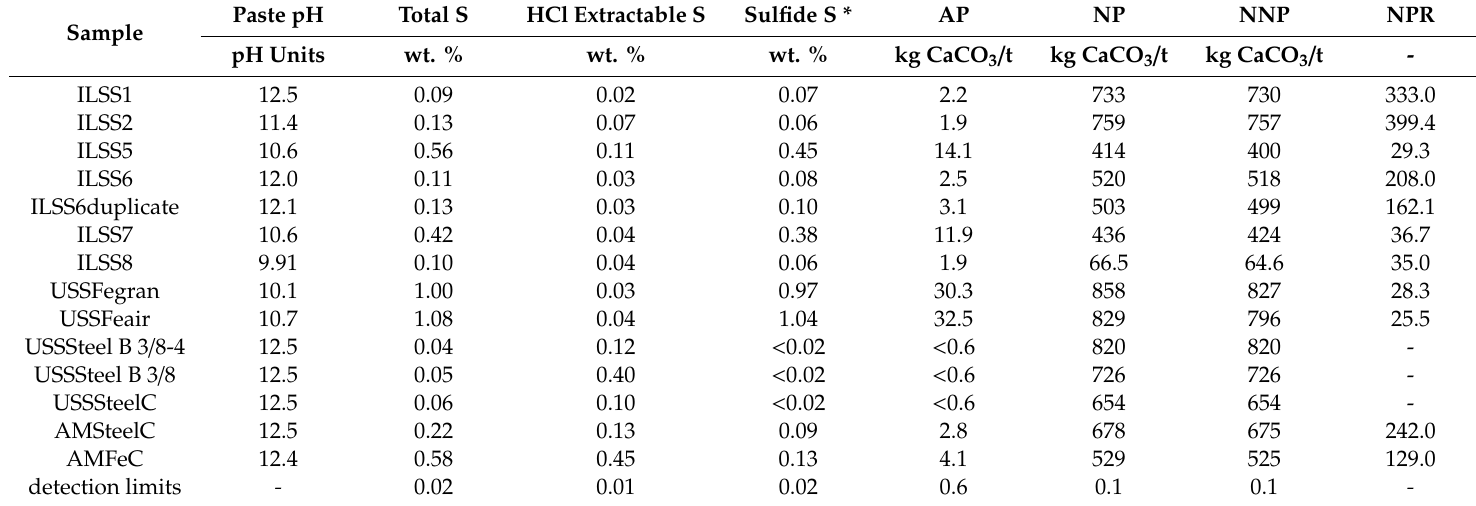
Table 2. Acid-base accounting results for iron and steel slag from the Chicago-Gary area, Illinois and Indiana. Acid-generating potential (AP), neutralization potential (NP), net neutralization potential (NNP), and neutralization potential ratio